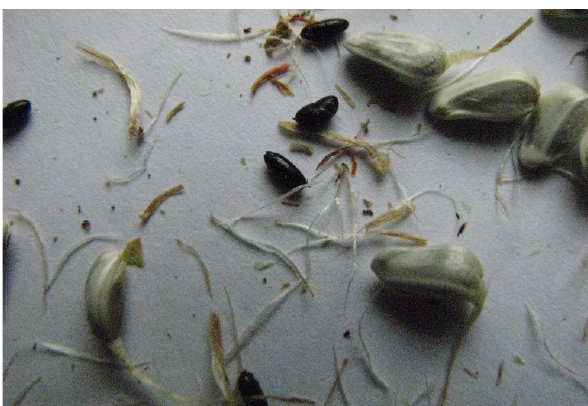
Fig. 7. Infested flower head including pupa of Acanthiophilus helianthi Rossi